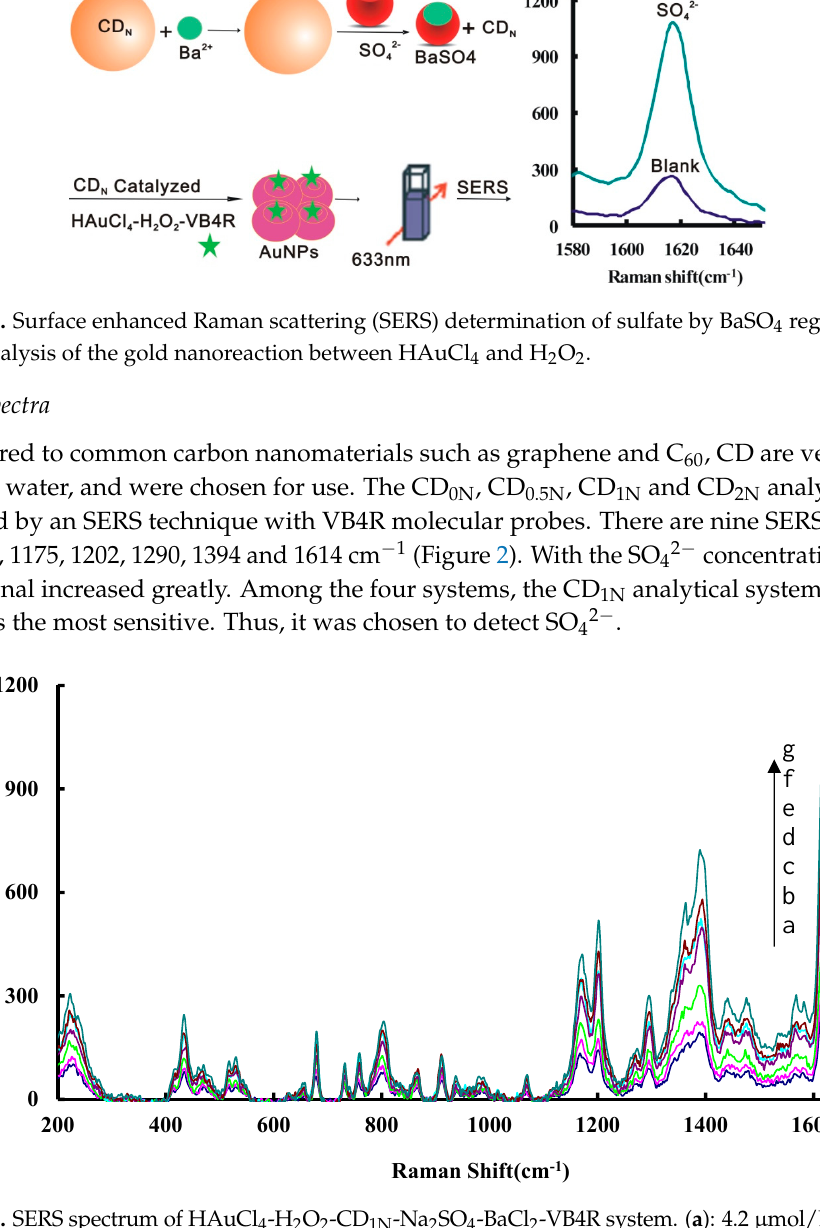
Figure 2. SERS spectrum of HAuCl 4 -H 2 O 2 -CD 1N -Na 2 SO 4 -BaCl 2 -VB4R system. ( a ): 4.2 μ mol/L HAuCl 4 + 2.5 mol/L H 2 O 2 + 5 μ g/mL CD 1N + 53 μ mol/L BaCl 2 + 0.33 μ mol/L VB4R; ( b ): a + 0.05 μ mol/L Na 2 SO 4 ;